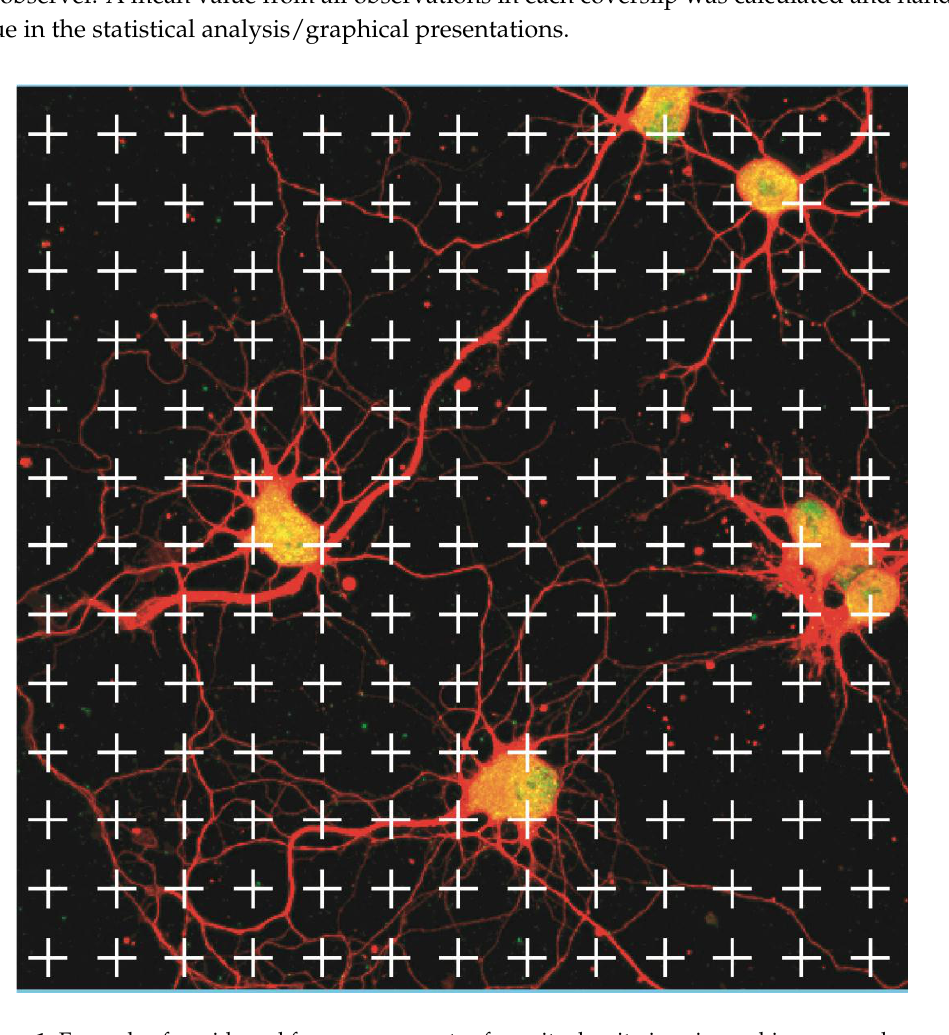
Figure 1. Example of a grid used for measurements of neurite density in primary hippocampal neuron cultures. A cross covering one or more neurites was considered one observation. A cross placed above a cell nucleus was not counted. To exemplify, arrows mark crosses that should be considered one observation, while arrowheads marks crosses that should be considered no observation. (red = beta III tubulin, green/yellow =